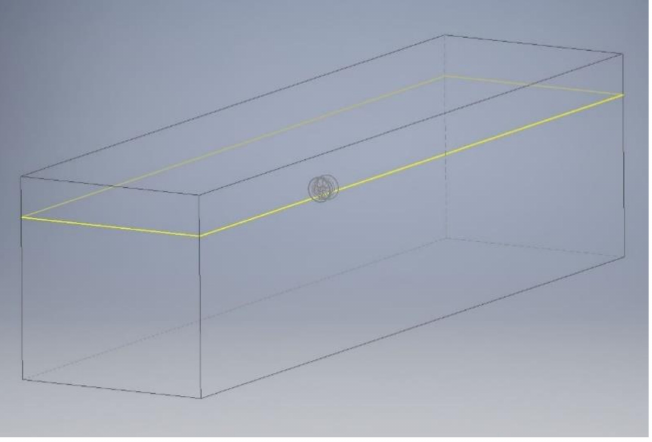
Figure 4. 3D geometry of open hexahedral CFD channel (LIVT